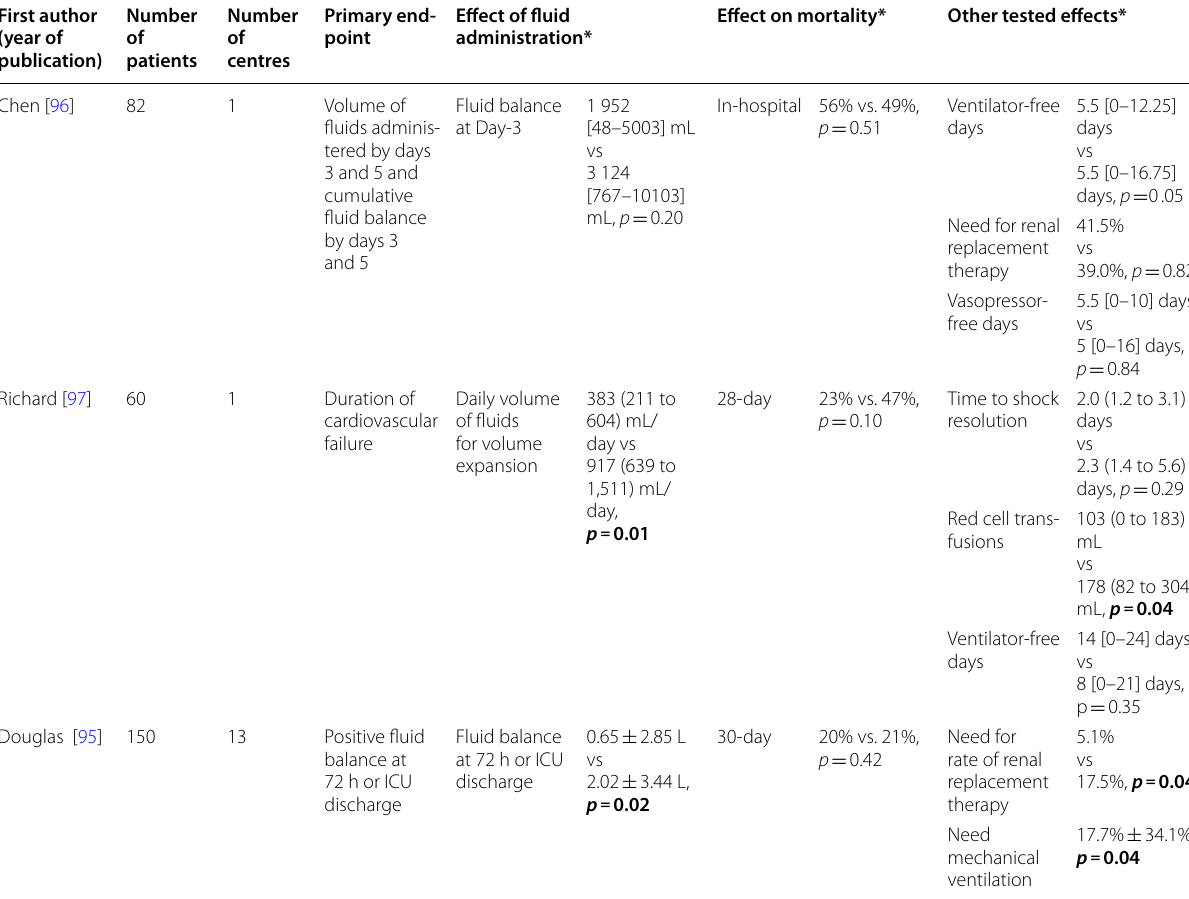
Table 3 Summary of the studies investigating the effects on the outcome of strategies using an assessment of preload responsiveness of critically ill